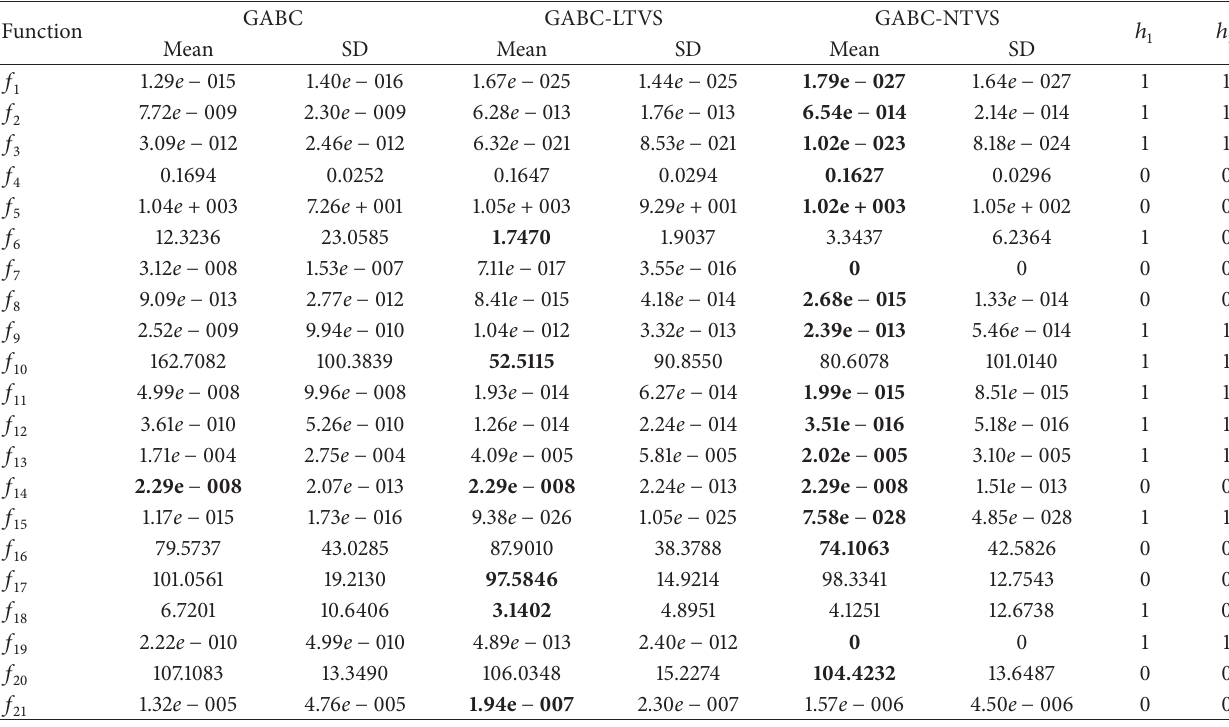
Table 8: Experimental results for 50D problem of GABC